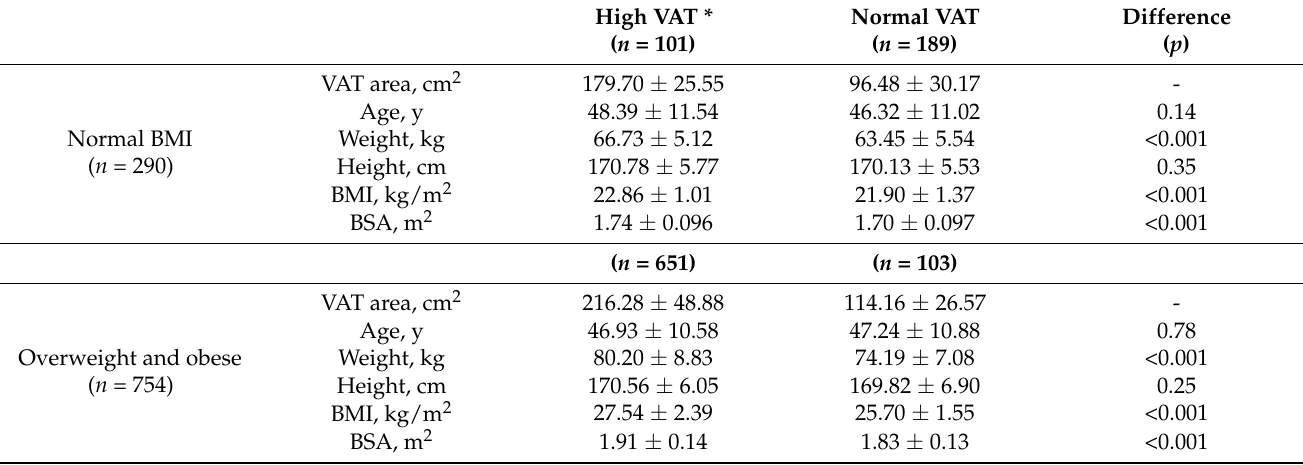
Table 1. Descriptive characteristics of Chinese men ( n = 1044) according to BMI and visceral fat. High VAT *